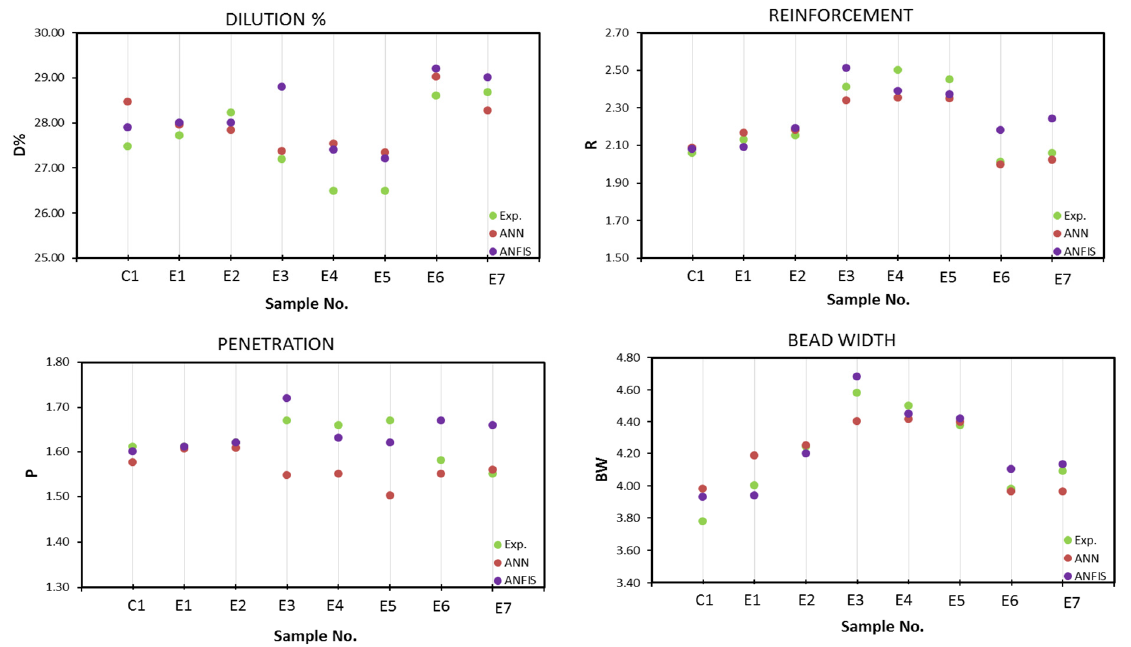
Figure 12. Comparison between experimental and prediction models for runs outside the input experimental design.